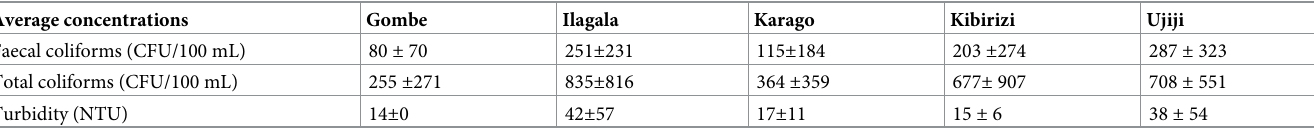
Table 3. Average and standard deviation of coliform and turbidity for each study site (n = 36). Average concentrations